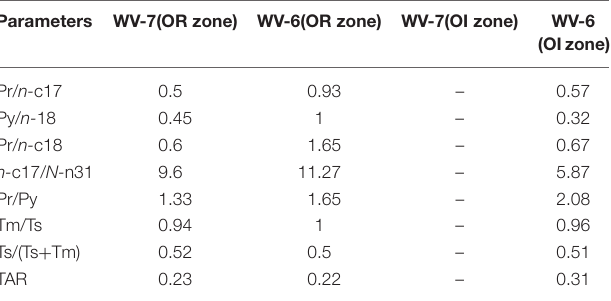
TABLE 2 | The biomarker ratios calculated from samples collected from OR and OI zone in WV-6 and WV-7. Parameters WV-7(OR zone) WV-6(OR zone) WV-7(OI